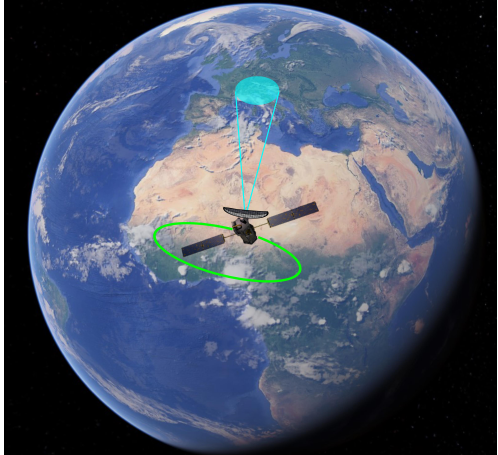
Figure 1. Hydroterra Near-Zero Inclination (NZI) scheme. Operating from geosynchronous orbit (GEO), imaging can be provided over most of Europe and Africa. The size of the ellipse has been exaggerated with respect to a real NZI GEO satellite orbit for